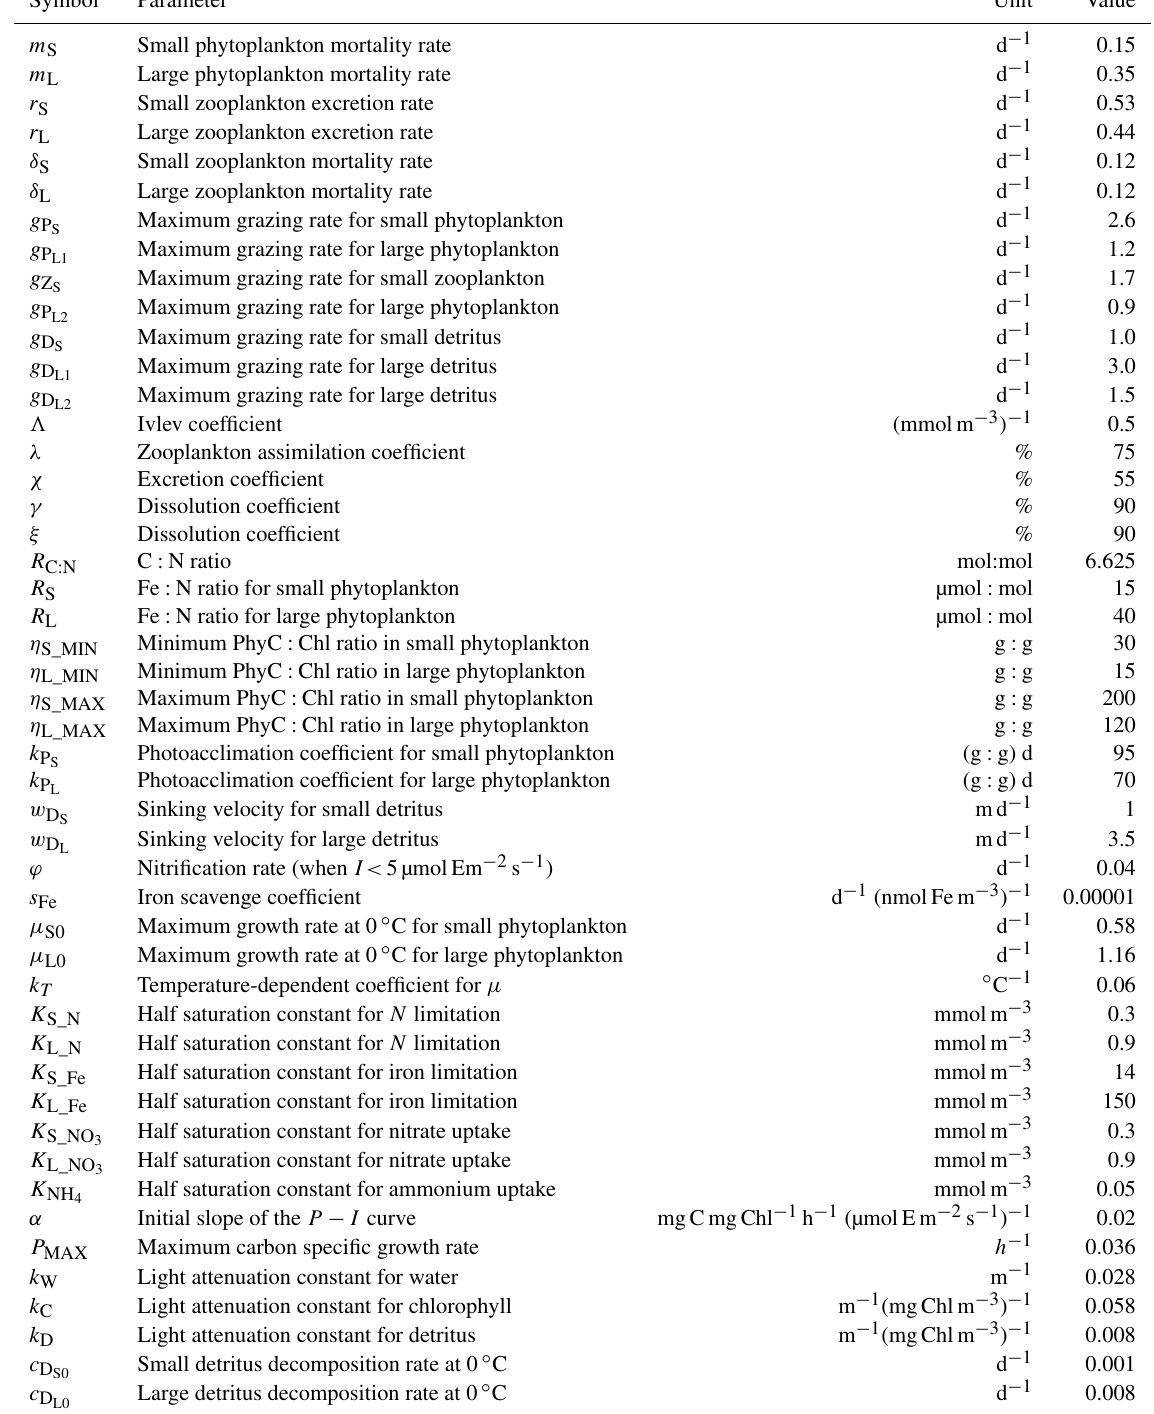
Table B1. Model biogeochemical